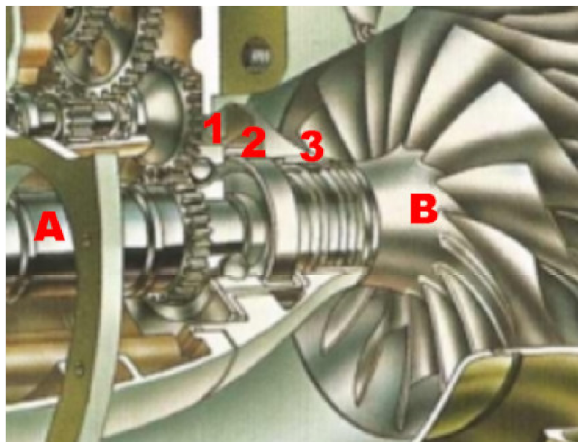
Figure 4. Garrett TPE331 turboprop engine cutaway drawing (detail based on [20]). A. main shaft.